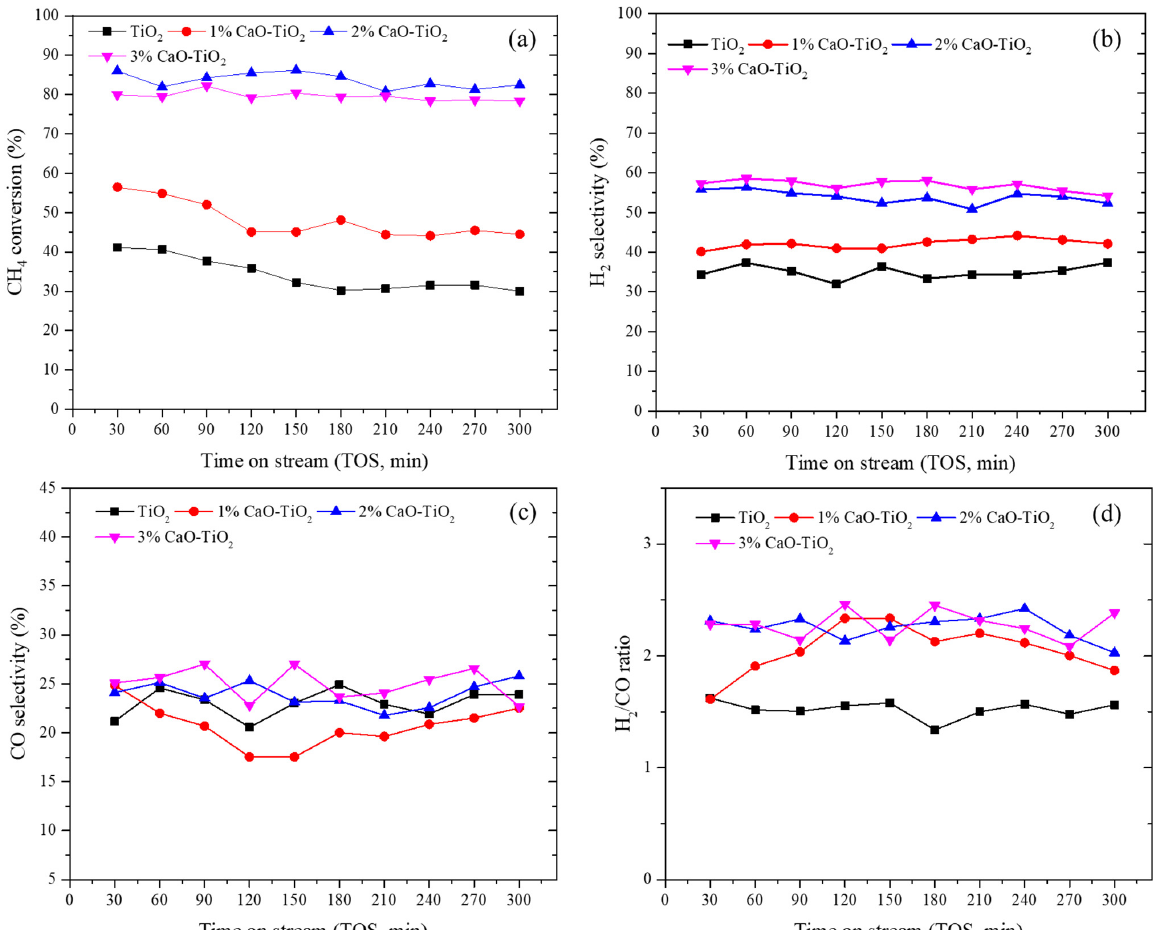
Figure 7. Catalyst stability performance: ( a ) CH 4 conversion; ( b ) H 2 selectivity; ( c ) CO selectivity; ( d ) H 2 /CO ratio; catalyst loading 0.2 g, reaction temperature, 750 °C, input ratio 40 mL/min (CH 4 = 20 ( d ) H 2 /CO ratio; catalyst loading 0.2 g, reaction temperature, 750 ◦ C, input ratio 40 mL/min mL/min, O 2 = 10 mL/min and N 2 = 10 mL/min). (CH 4 = 20 mL/min, O 2 = 10 mL/min and N 2 = 10